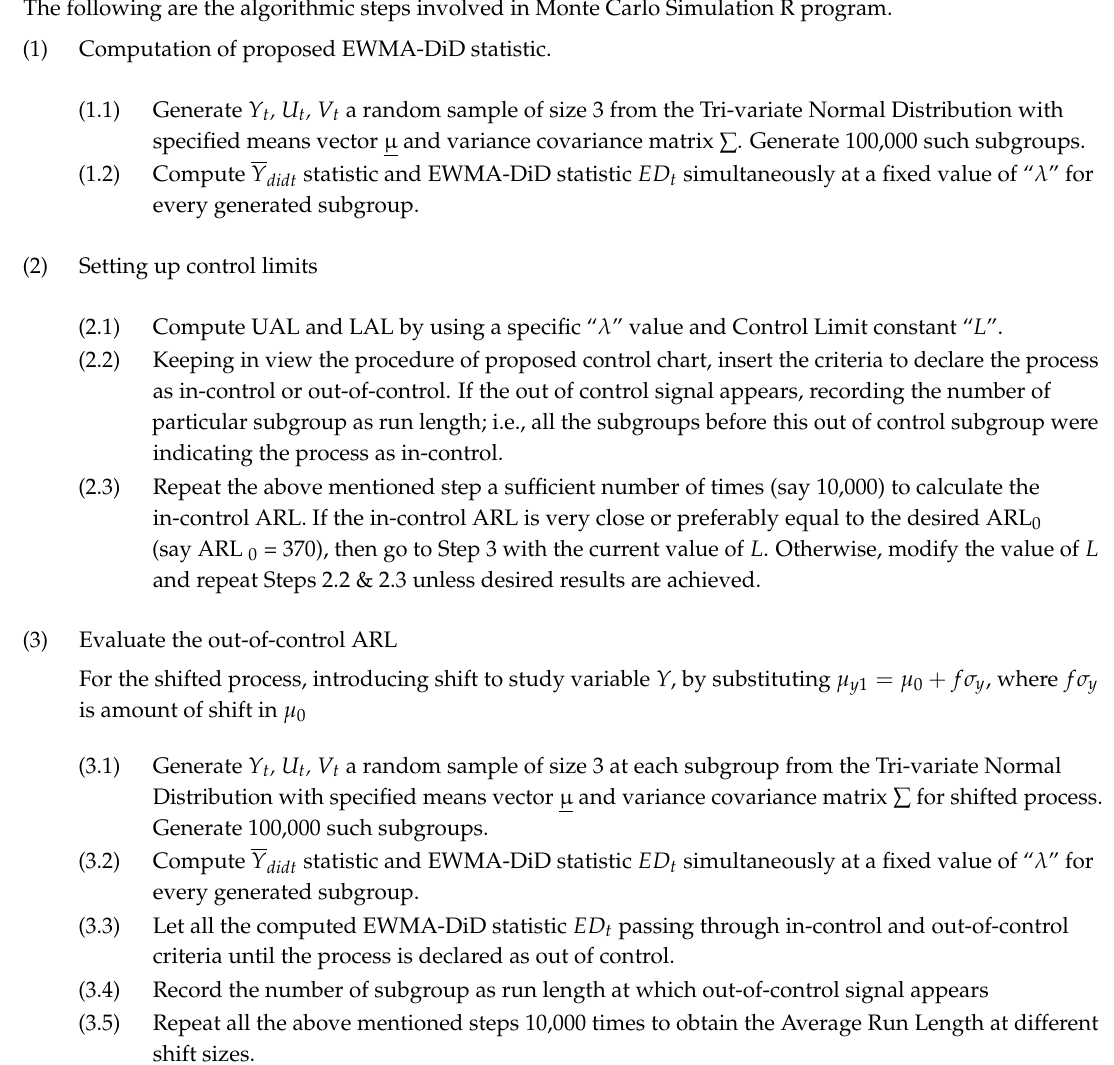
Algorithm 1. Monte Carlo Simulation Program of EWMA-DiD Control Chart for in-control and shifted process The following are the algorithmic steps involved in Monte Carlo Simulation R